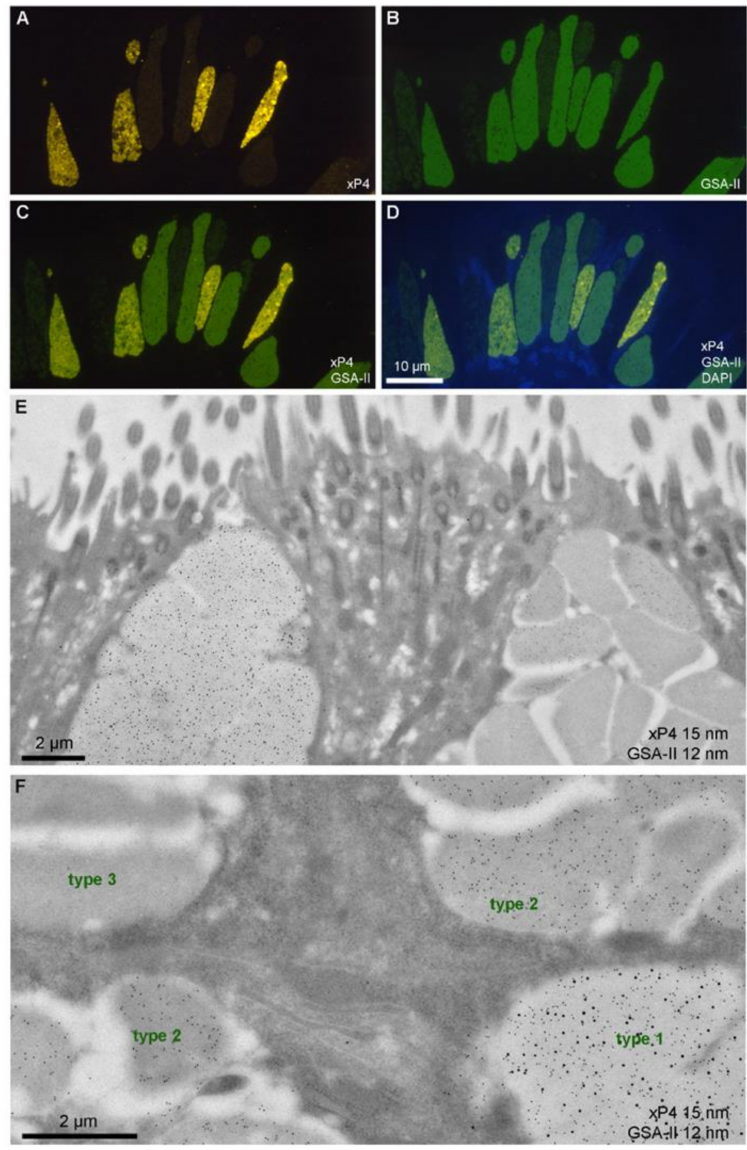
Figure2. Labeledultrathinmethacrylate(LowicrylK11M)sectionsof X.laevis esophagus. (A–D) Fluorescence microscopy of a single section labeled for xP4 with antiserum anti-xP4-1 (Cy3, yellow), mucin with GSA-II (FITC, green), and DNA of cell nuclei with DAPI (blue): xP4 ( A ), GSA-II ( B ), xP4 / GSA-II double exposure ( C ), and xP4 / GSA-II / DAPI triple exposure ( D ); scale bar: 10 µ m. (E, F) Electron micrographs of gold labeling with the anti-xP4-1 antiserum (detected with protein A-15 nm gold particles) and mucin staining with GSA-II (12 nm gold conjugates) at two orthogonal orientations of the sectioning planes. The three types of secretory granules are marked in ( F ); scale bars: 2 µ